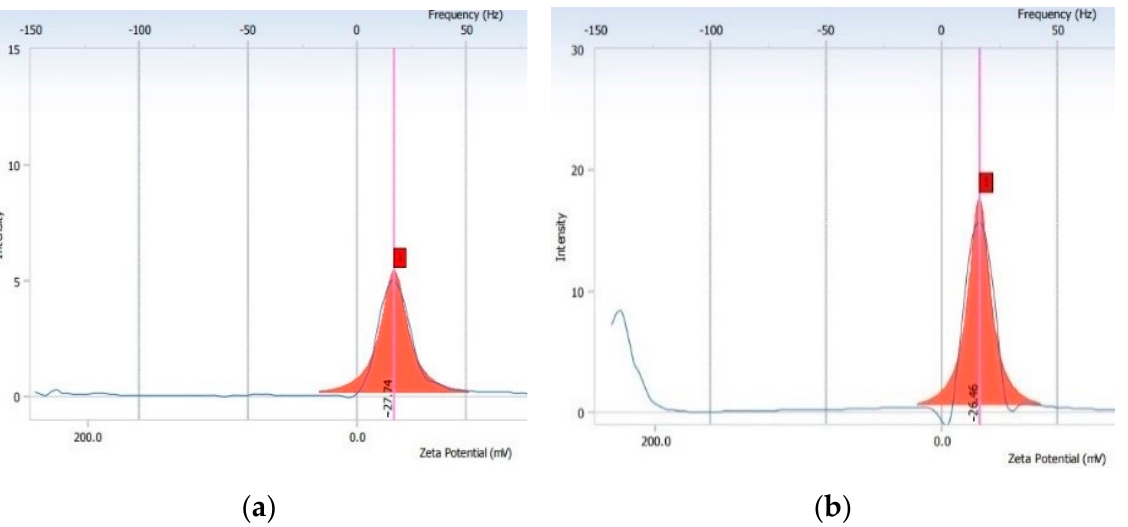
2 O ( a ) and of AgNPs-EtOH ( b